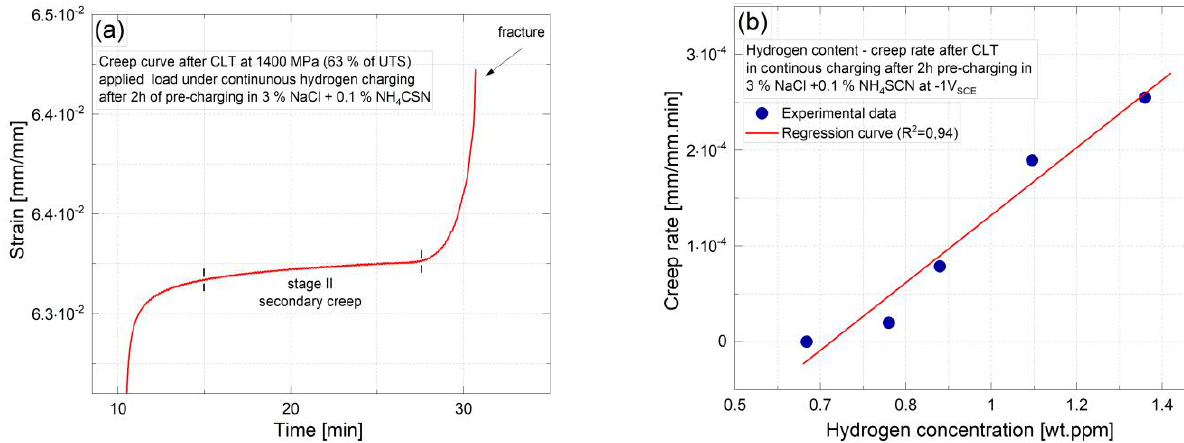
Figure 8. ( a ) Engineering strain versus time curve from CLT at 1400 MPa under continuous hydrogen charging; ( b ) creep rates as a function of hydrogen concentration.